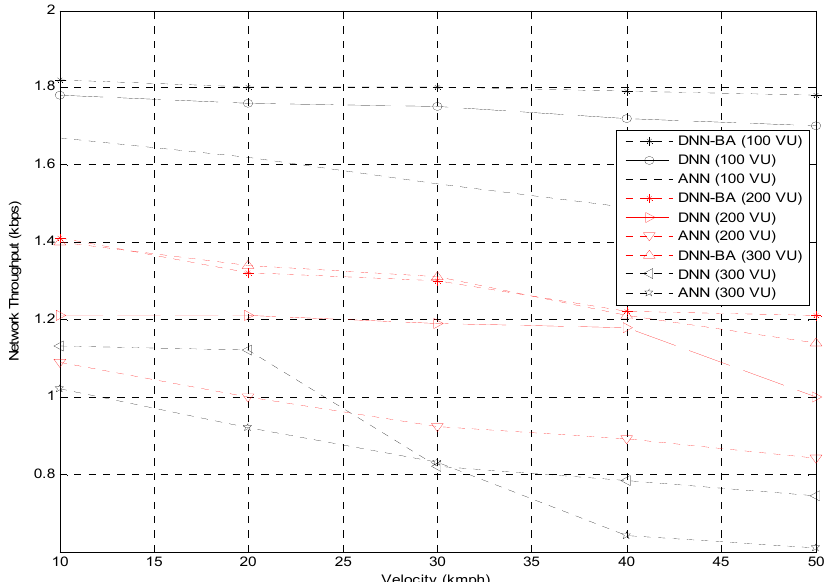
Figure 8. Impacts on throughput with variable velocity.